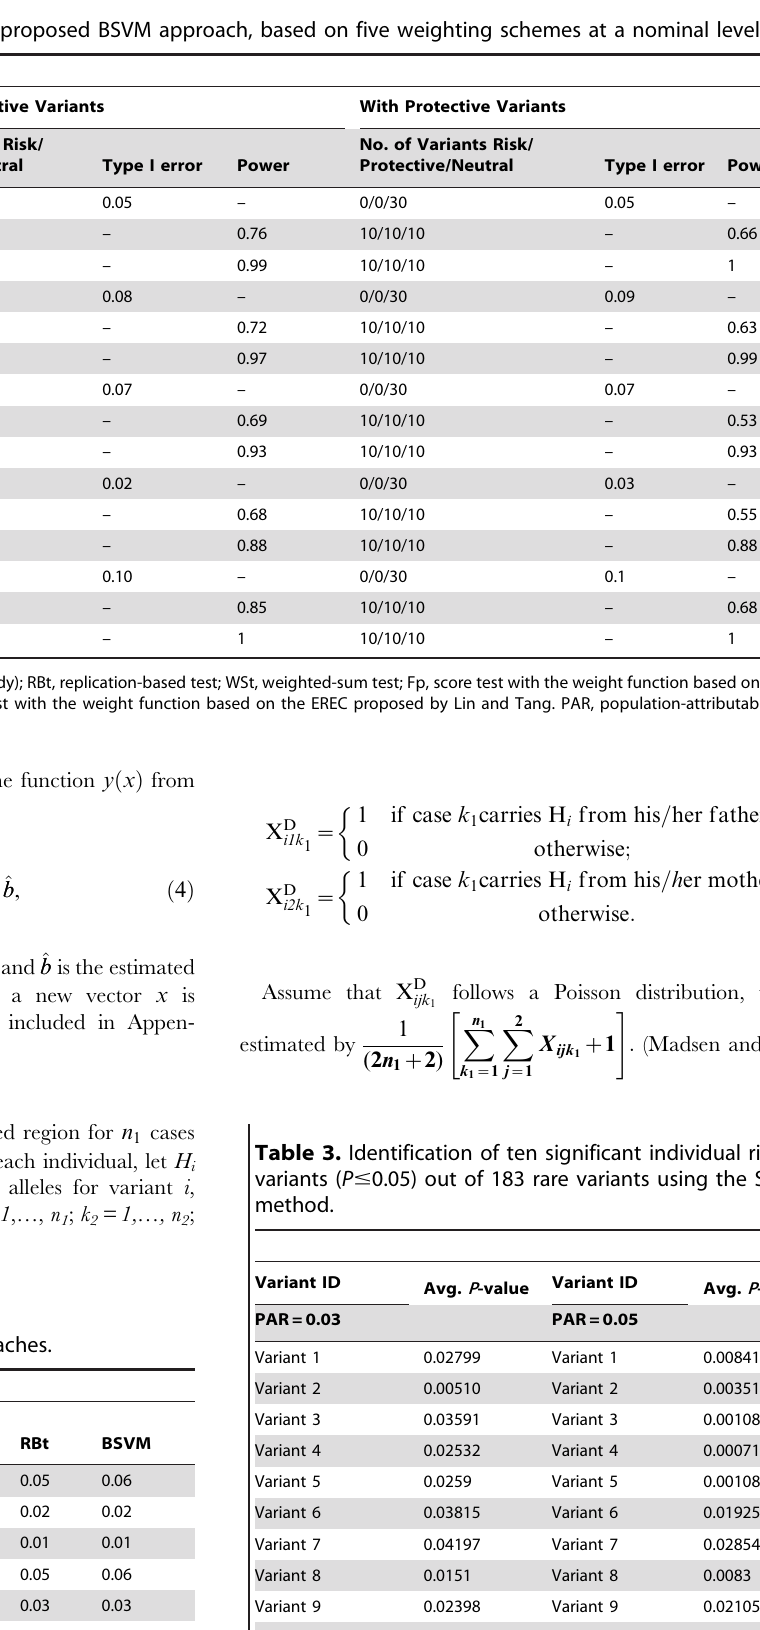
Table 1. Type I error and power of the proposed BSVM approach, based on five weighting schemes at a nominal level of 0.05.